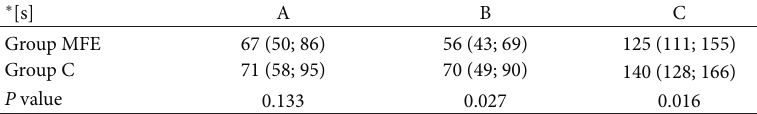
Figure 2: Obtaining of peripheral venous access in the studied groups.